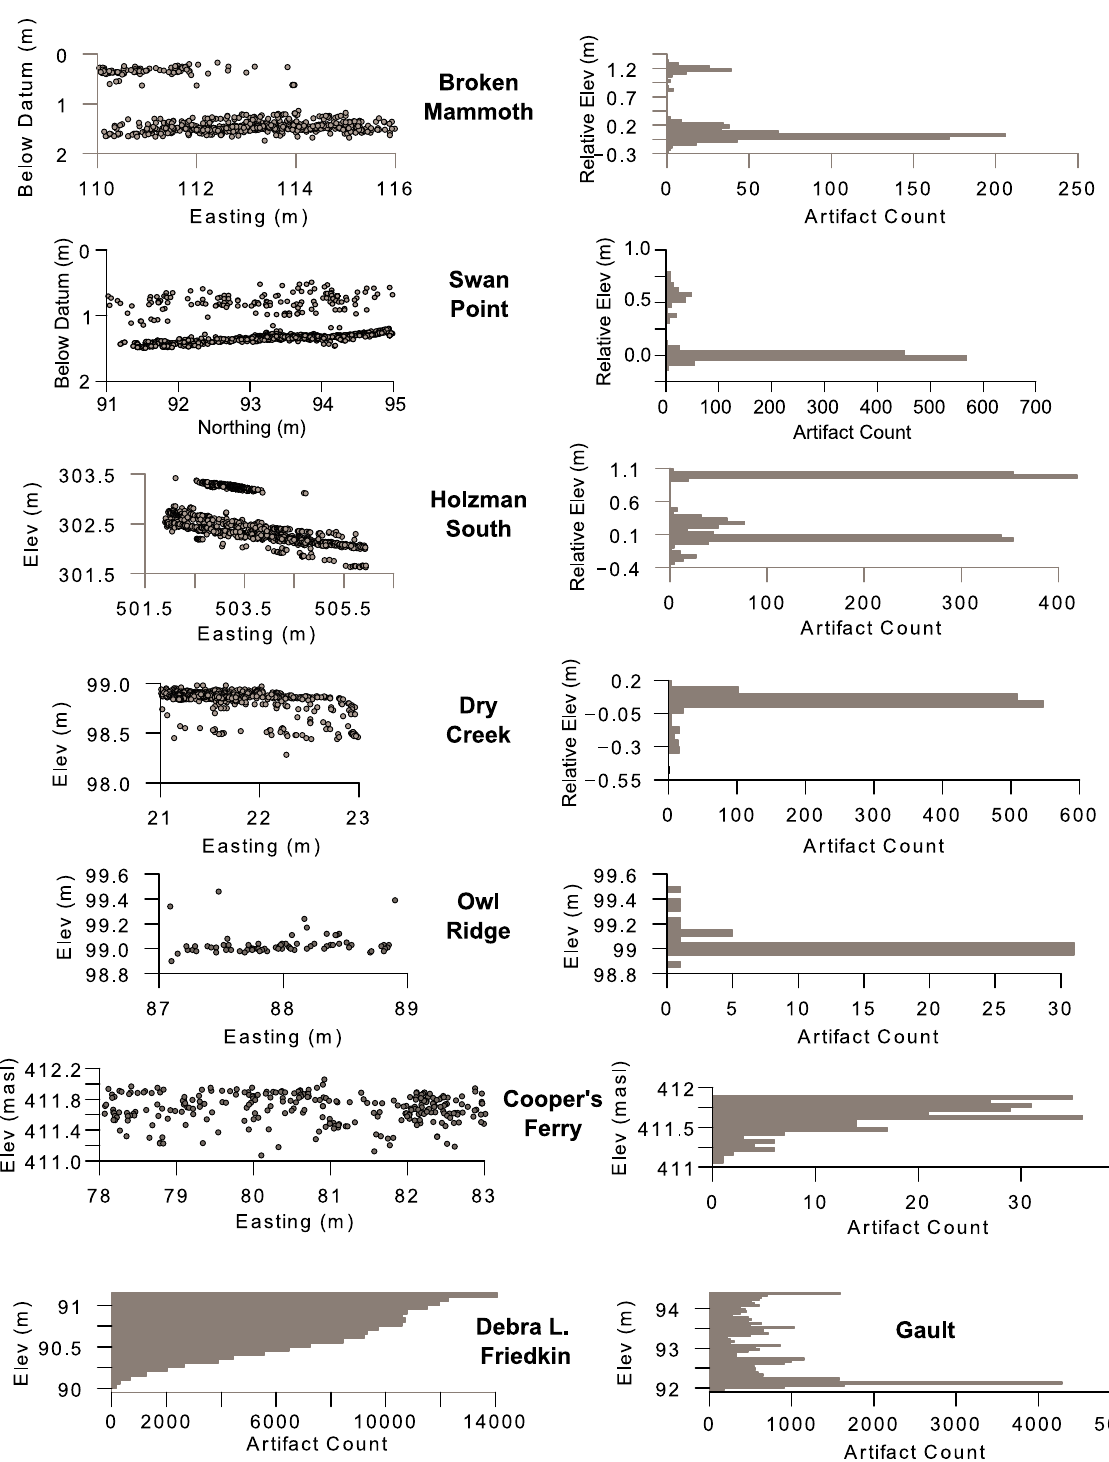
Fig 5. Backplots and/or vertical density histograms for all pre-13,000 BP archaeological sites in the study.